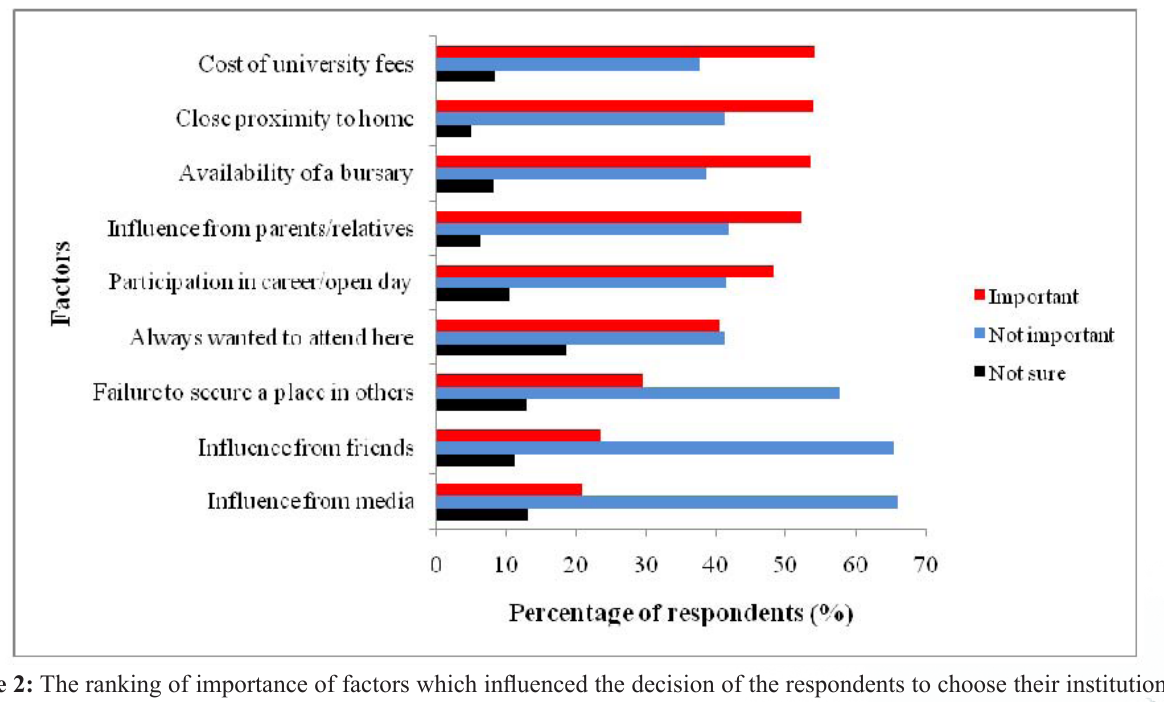
Figure 2: The ranking of importance of factors which influenced the decision of the respondents to choose their institution of learning. A few rated the influence from friends (23.5%) and media (20.9%) as important factors.